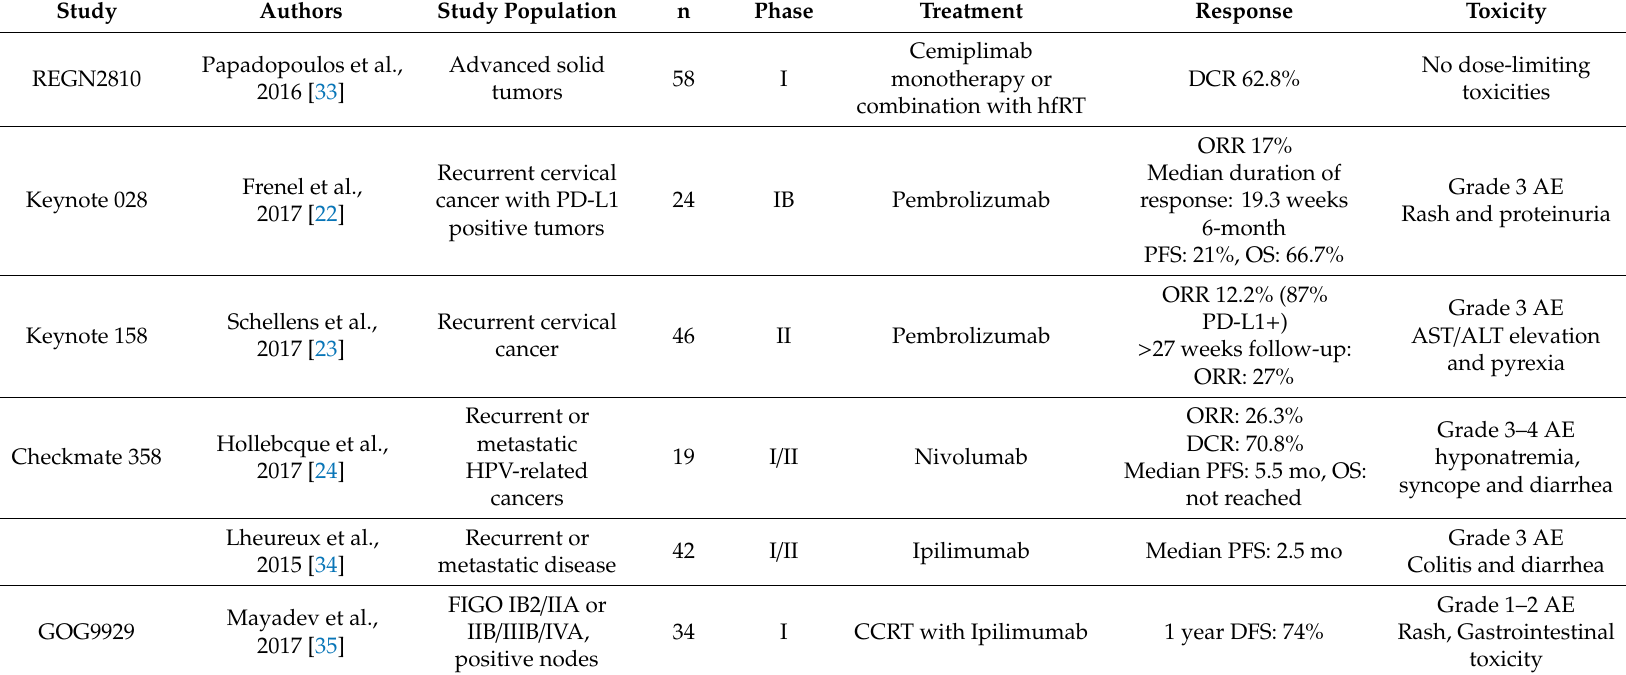
Table 1. Clinical research outcomes of immunotherapy in cervical